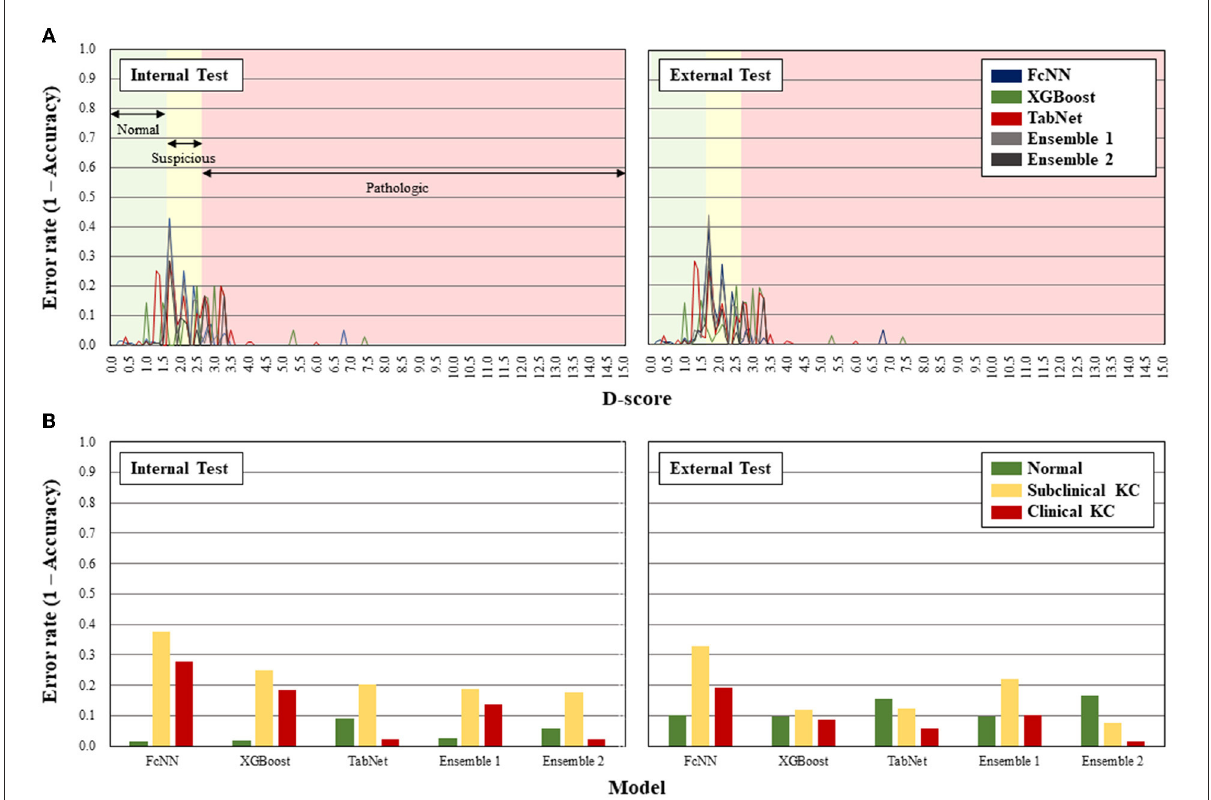
FIGURE2 Error rates of the artificial intelligence models according to D-score of Belin-Ambrósio enhanced ectasia display (A) and classification of subclinical and clinical keratoconus (B)